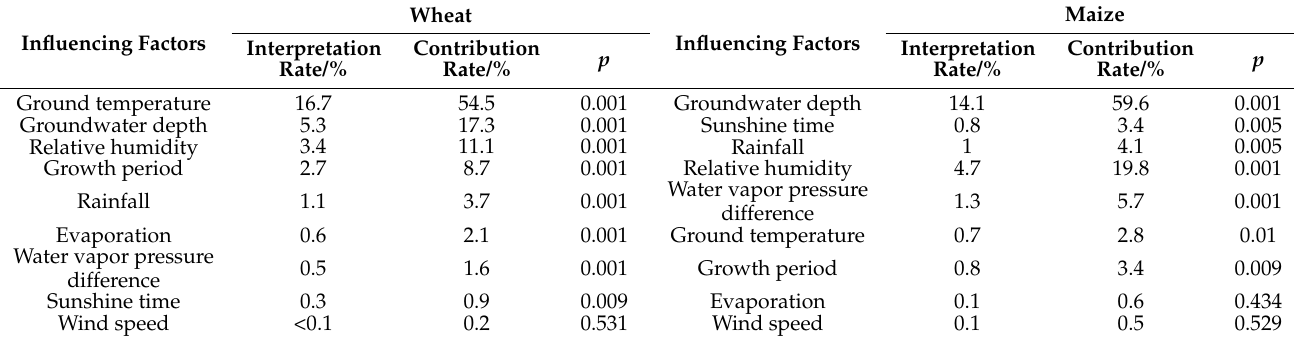
Figure 5. Soil moisture content of wheat and maize and the influencing factors RDA analysis ranking. Table 6. Forward selection of influencing factors in RDA analysis and Monte Carlo test.